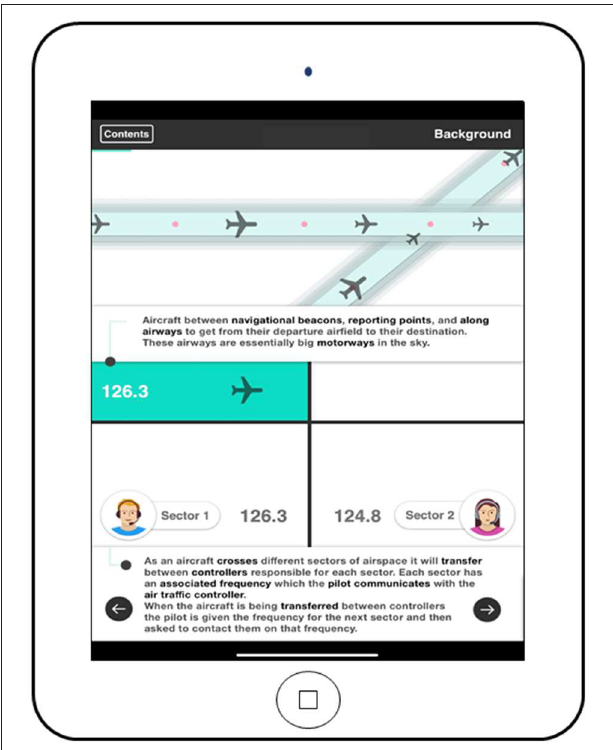
FIGURE 8 | “Background” screen of the ACPO starter